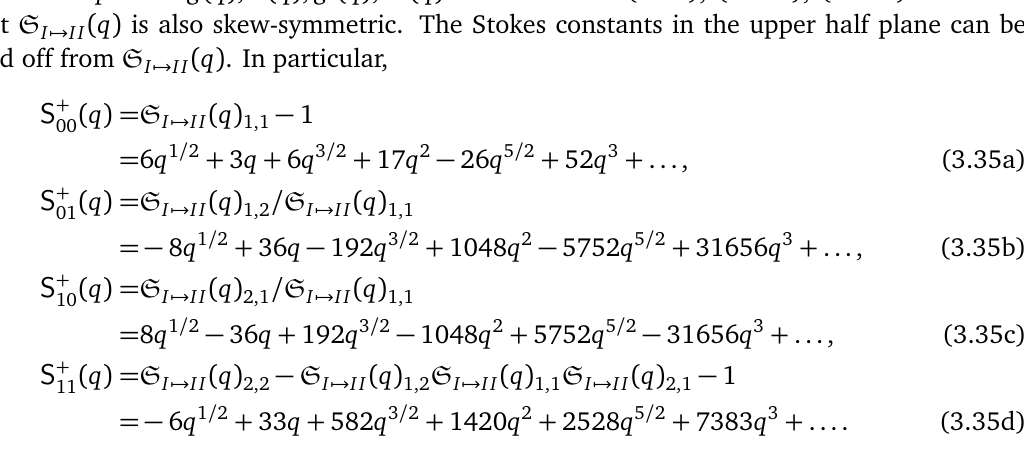
Figure 5: Stokes constants for the minimal resurgent structure { Φ local (cid:70) 0